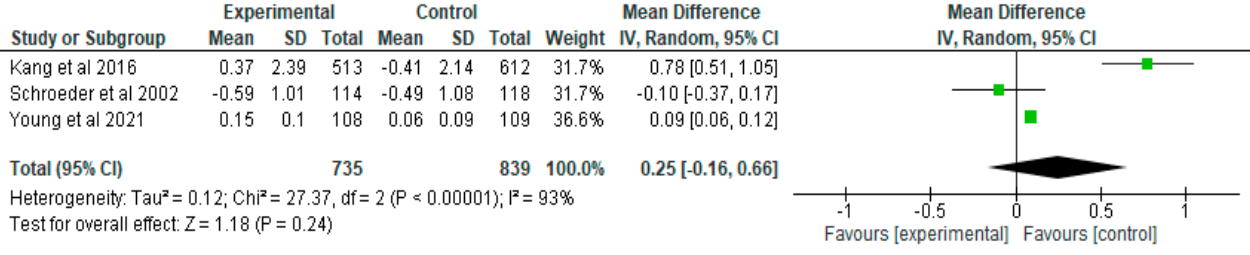
Figure 6. Results pooled data on the e ff ect of positive deviance interventions on WHZ [28–30].